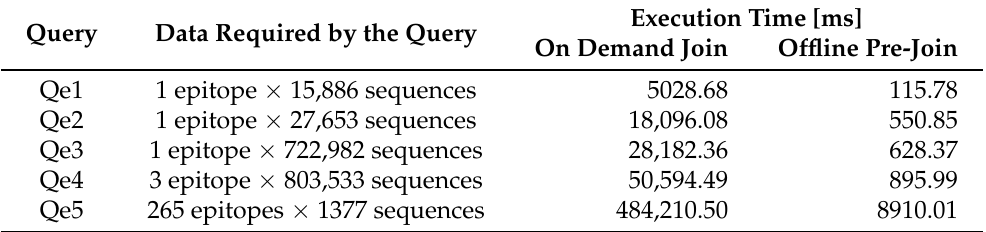
Table 5. Performance measurements of the queries Qe1–5 . The measurement in the column “On- demand join” are obtained by running the queries without using the pre-computed tables of mutation and epitopes. The following columns report the timings observed when executing the same queries using the pre-computed tables.